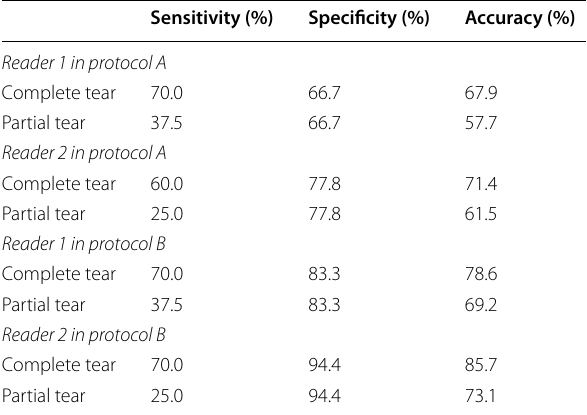
Table 9 The MR sensitivity, specificity and accuracy for the diagnosis of ACL graft partial and complete